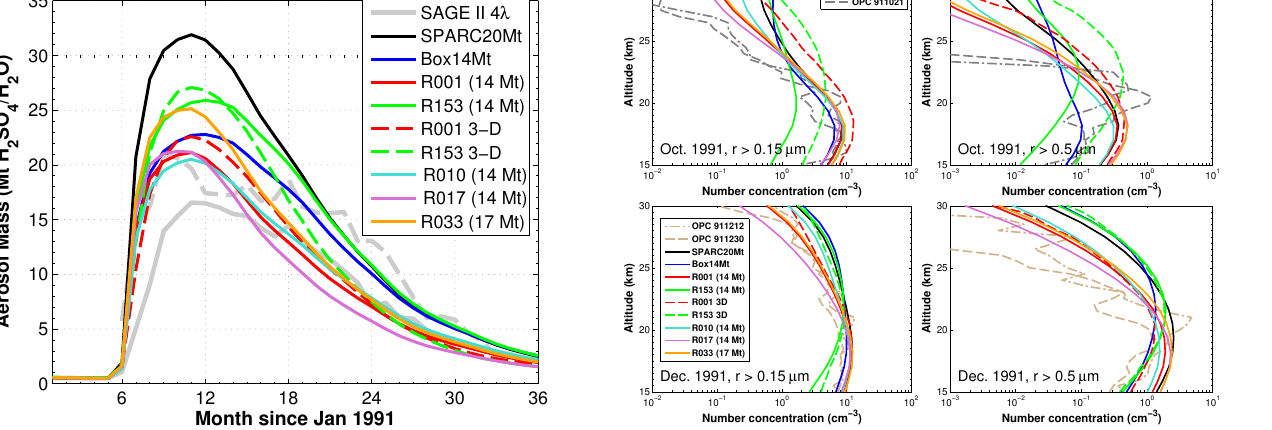
Figure 3. Evolution of simulated global stratospheric aerosol bur- den (Mt H 2 SO 4 /H 2 O) compared to the HIRS and SAGE II-derived data. HIRS-derived data include both tropospheric and stratospheric aerosols (Baran and Foot, 1994). SAGE II aerosol data is derived from the retrieval algorithm SAGE 4 λ by Arfeuille et al. (2013), and includes only stratospheric aerosols.